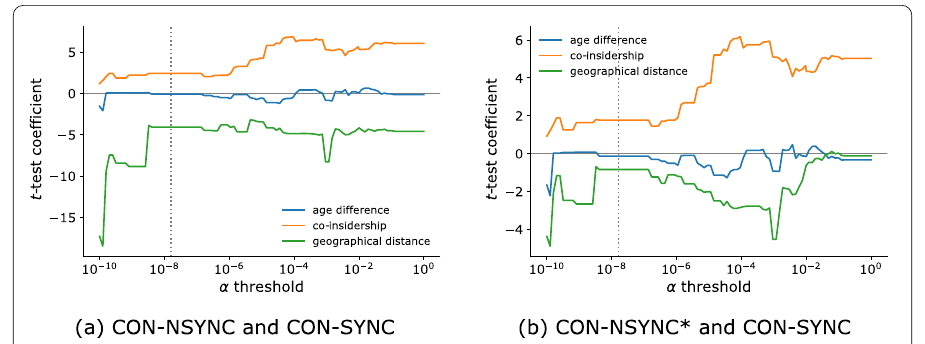
Figure 5 Welch’s t -statistic on the differences in age, length of co-insidership and geographical distance between (a) CON-NSYNC (Eq. (9)) and CON-SYNC (Eq. (8)) sets, and (b) CON-NSYNC ∗ (Eq. (10)) and CON-SYNC sets. The statistic is reported for 100 log-spaced α thresholds used for the validation of investors’ trade synchronization. The dotted vertical line marks the Bonferroni validation